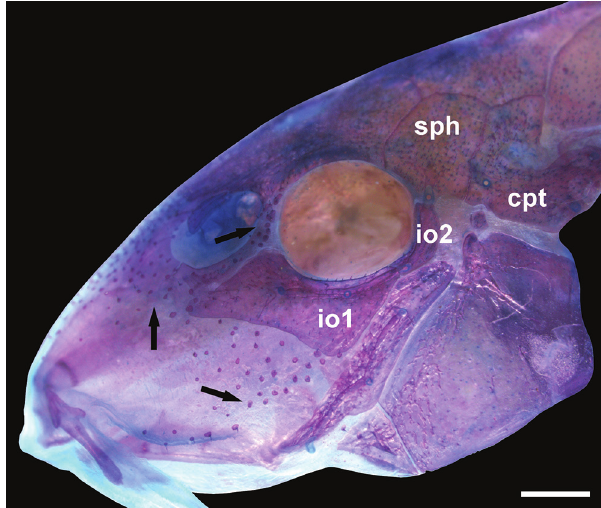
Fig. 4. Aspidoras kiriri , NUP 18246, c&s paratype, 30.4 mm SL, lateral view of the head. Arrows indicate small platelets.